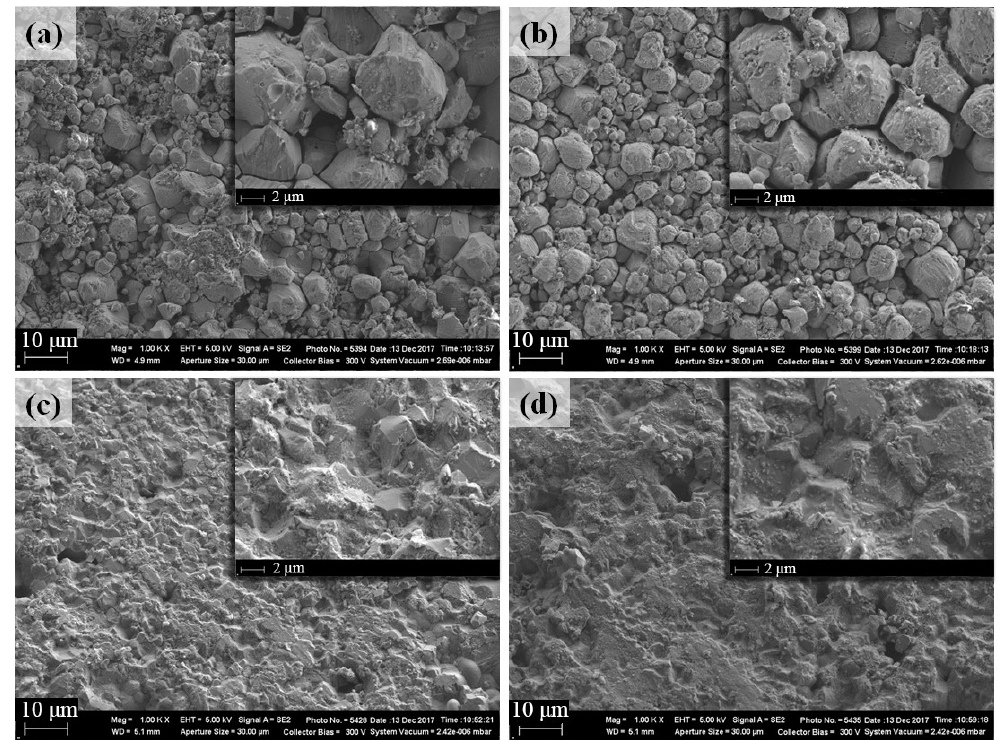
Figure 4. Surface morphology images for the as-sintered (1 − x)Sr 2 Mg 0.25 Ni 0.75 MoO 6 − δ + xNiO ceramic materials: x = 15 ( a ), x = 30 ( b ), x = 70 ( c ) and x = 85 ( d ).